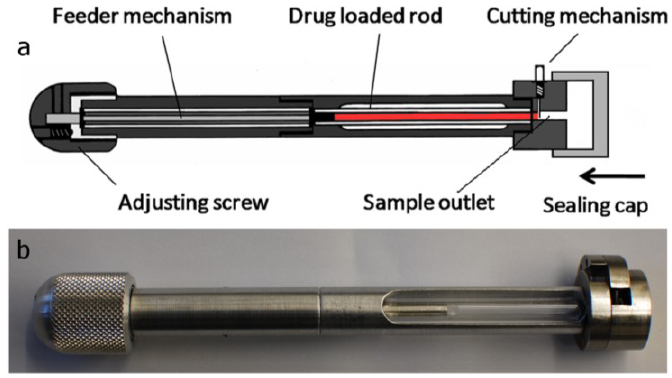
Figure 2. ( a ) Schematic drawing of modified SDP suitable for cutting of effervescent extrudates into individual doses; ( b ) Photograph of a constructed prototype.